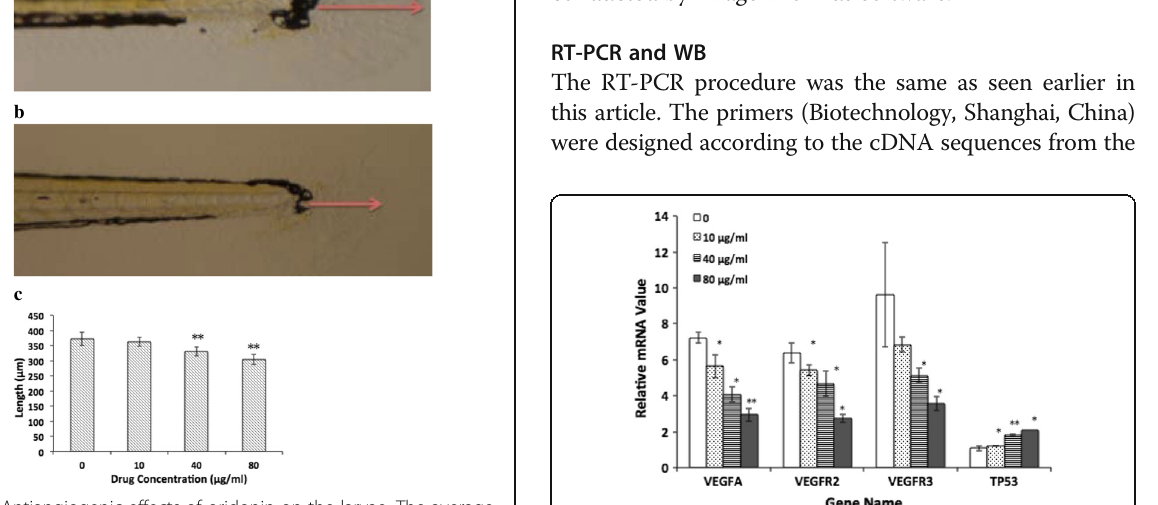
Fig. 7 Antiangiogenic effects of oridonin on the larvae. The average lengths of the regenerated tissues were measured and calculated. a control group; b 80 μ g/ml oridonin group; c Length comparison. The asterisks indicate statistically significant differences from the control group (* P < 0.05, ** P < 0.01)